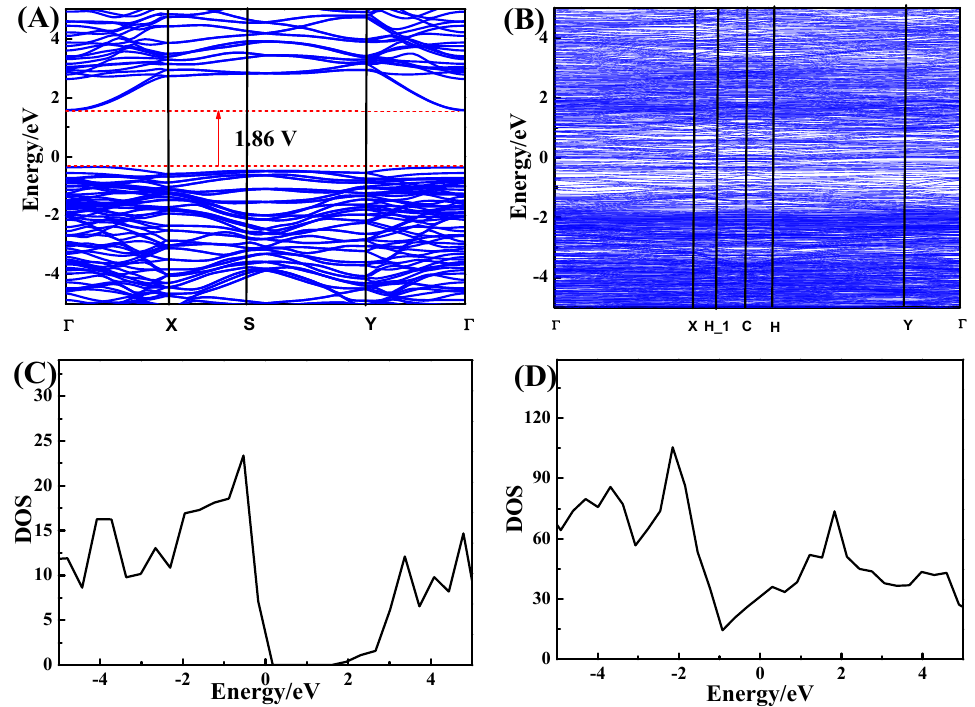
Figure 5. Band structures for ( A ) Bi 2 WO 6 and ( B ) CuS/MoS 2 /Bi 2 WO 6 and DOS for ( C ) Bi 2 WO 6 and ( D ) CuS/MoS 2 /Bi 2 WO 6 − 5%.